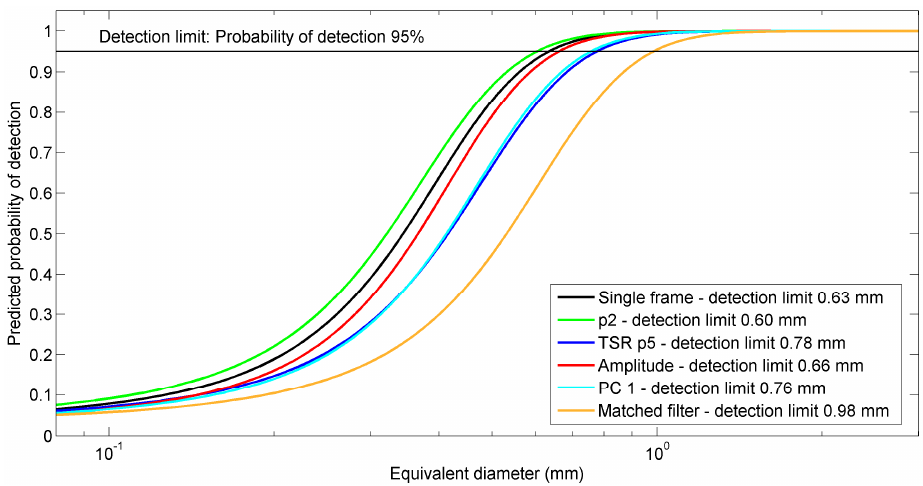
Figure 11. Predicted probability of detection as a function of the equivalent diameter for six thermal output images “single frame”, “p 2 ”, “TSR p 5 ”, “amplitude”, “PC1” and “matched filter”. A logarithmic scale is used for the x -axis. The detection limit is defined as the equivalent diameter at which the probability of detection is equal to 95%. The detection limit for each processing method is reported in the legend.